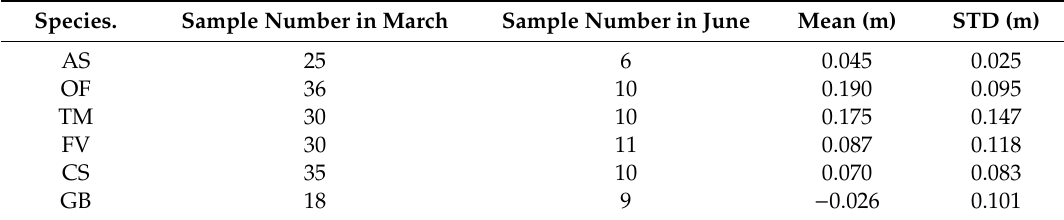
Table 2. Tree height changes due to natural growth between March and May. The average and standard deviation in tree growth values during this period are listed. The negative value for gingko is unreasonable and may be caused by measurement error, as it was sometimes hard to determine the highest point in the canopy, especially for the leafless